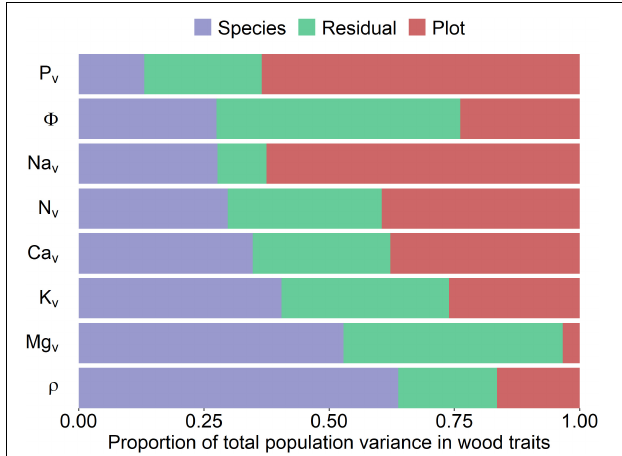
FIGURE 3 | Partitioning of the total variance for each woody property ( y -axis) into species, environmental (plot), and error (residual) components. Traits have been ranked according to the relative contribution of the species-associated variance component. All values were log 10 transformed prior to analysis with nutrients on a volumetric basis being used. Subscript “v” indicates that concentrations are on a volume basis. ρ , wood density; (cid:56) , water content per unit tissue